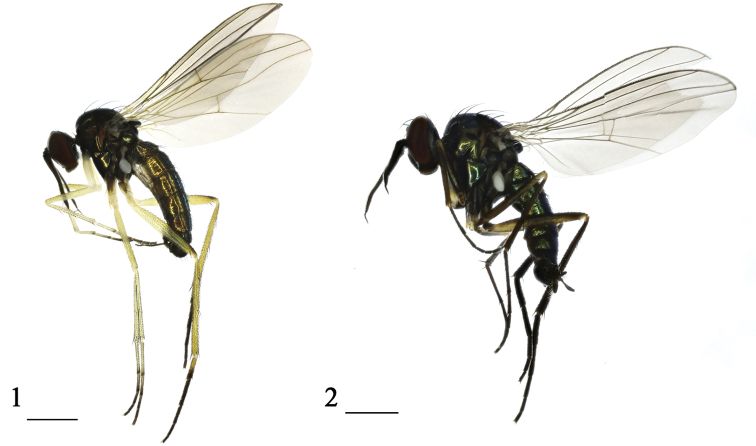
Habitus, lateral view 1Rhaphium
huzhuense sp. nov., holotype male 2Rhaphium
minhense sp. nov., holotype male. Scale bars: 1 mm.